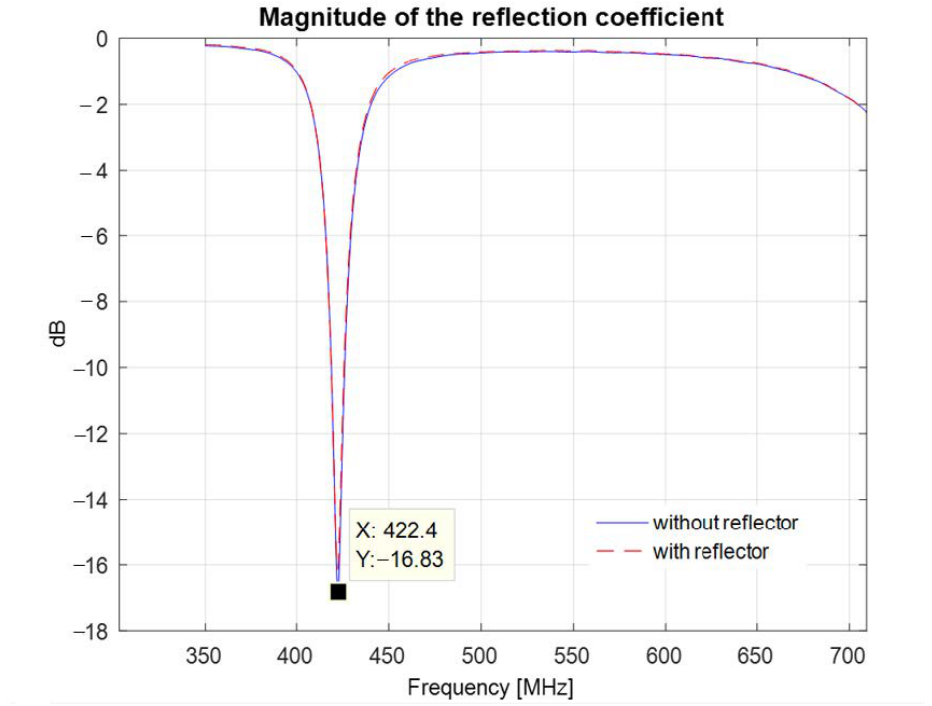
Figure 22. Magnitude of the reflection coefficient of the printed meander line monopole antenna with an input impedance matching circuit, measured with and without a reflector.